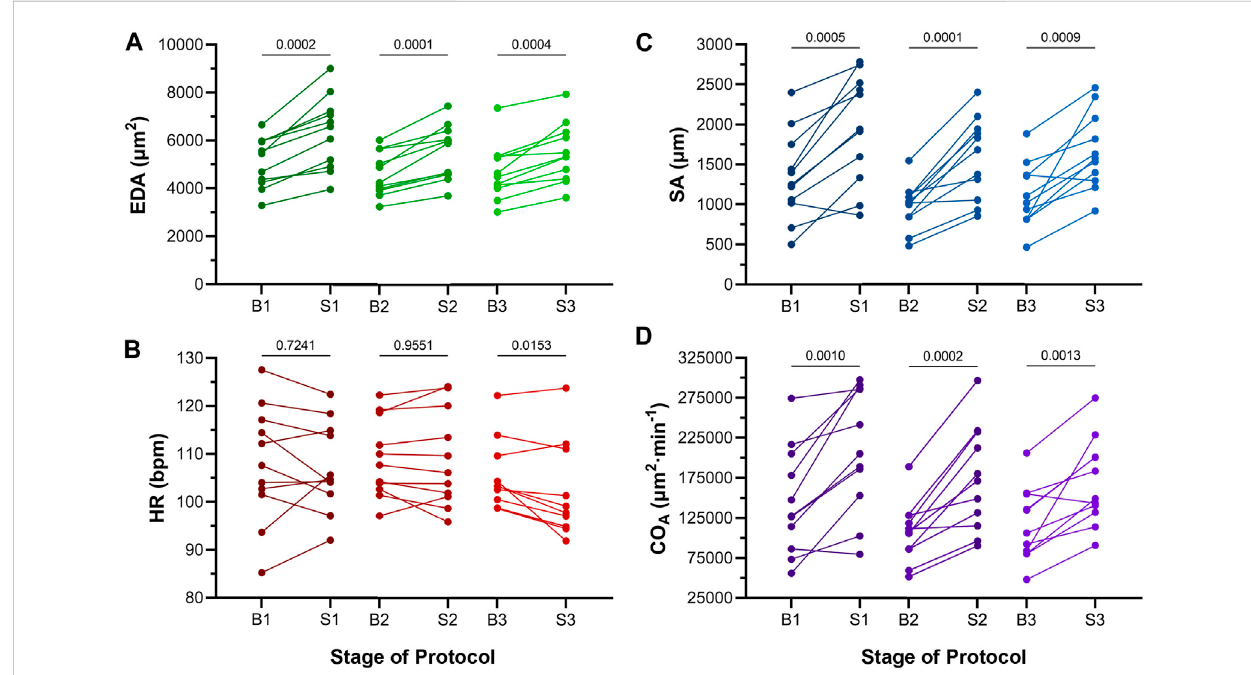
FIGURE 4 Effects of atrial dilation on functional parameters in 48 hpf zebra fi sh larvae. (A) End-diastolic area (EDA), (B) heart rate (HR), (C) stroke area (SA), and (D) area cardiac output